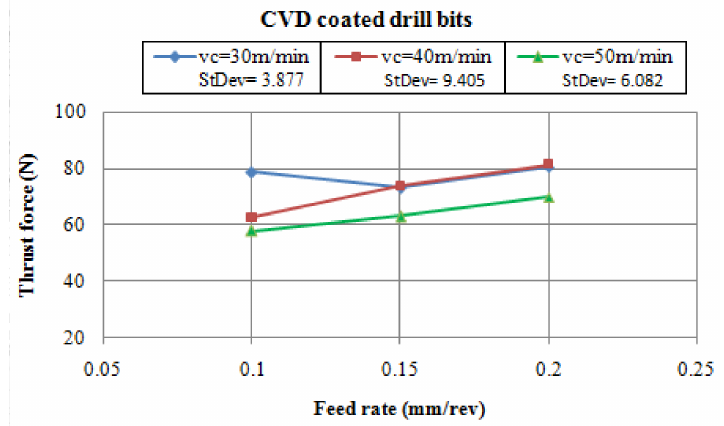
Figure 7. Thrust force variation with feed rates at different cutting speeds when using CVD-coated drill